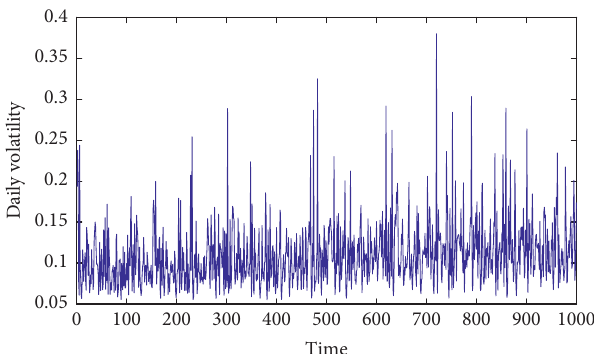
Figure 14: The simulated true volatility series.